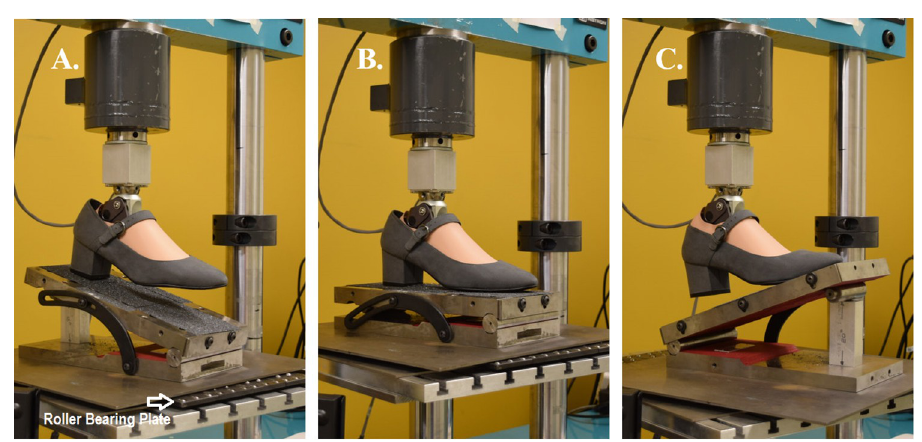
Fig 2. Test set up for each condition. A. Initial contact; B. midstance; C. terminal stance. Prosthesis and shoe images are similar but not identical to the original images and are therefore for illustrative purposes